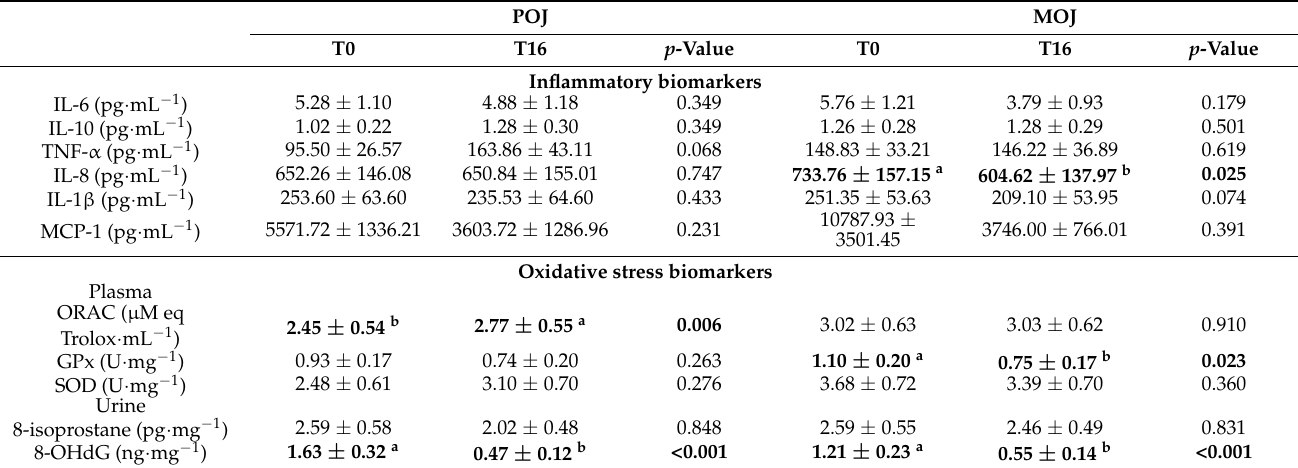
Pera and Moro orange juice